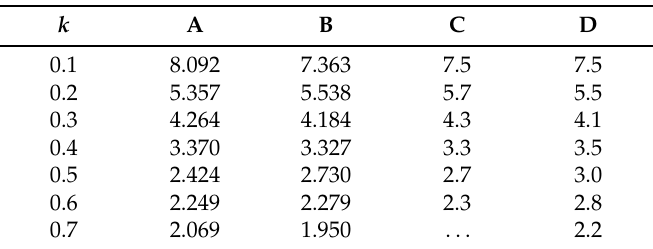
Table 4. Z eff (0) as a function of the incident positron momentum k , obtained in this calculation and compared with previous